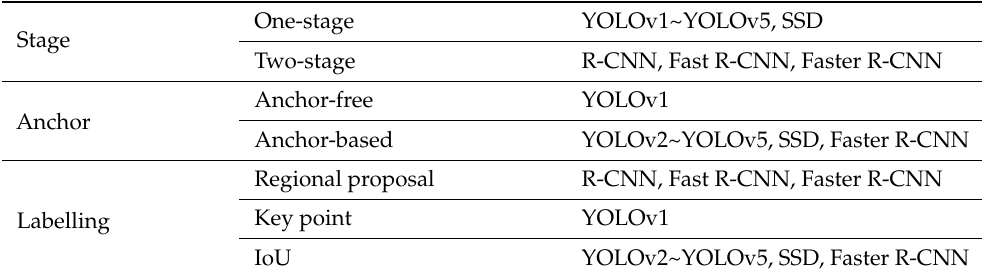
Table 1. Object detection algorithms